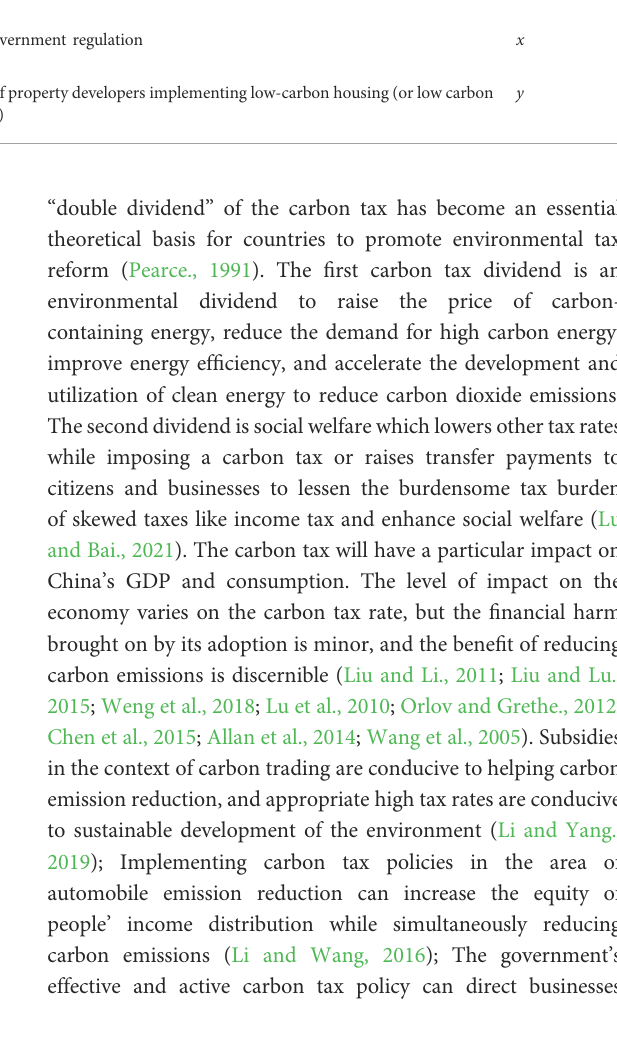
TABLE 2 Game pay-off